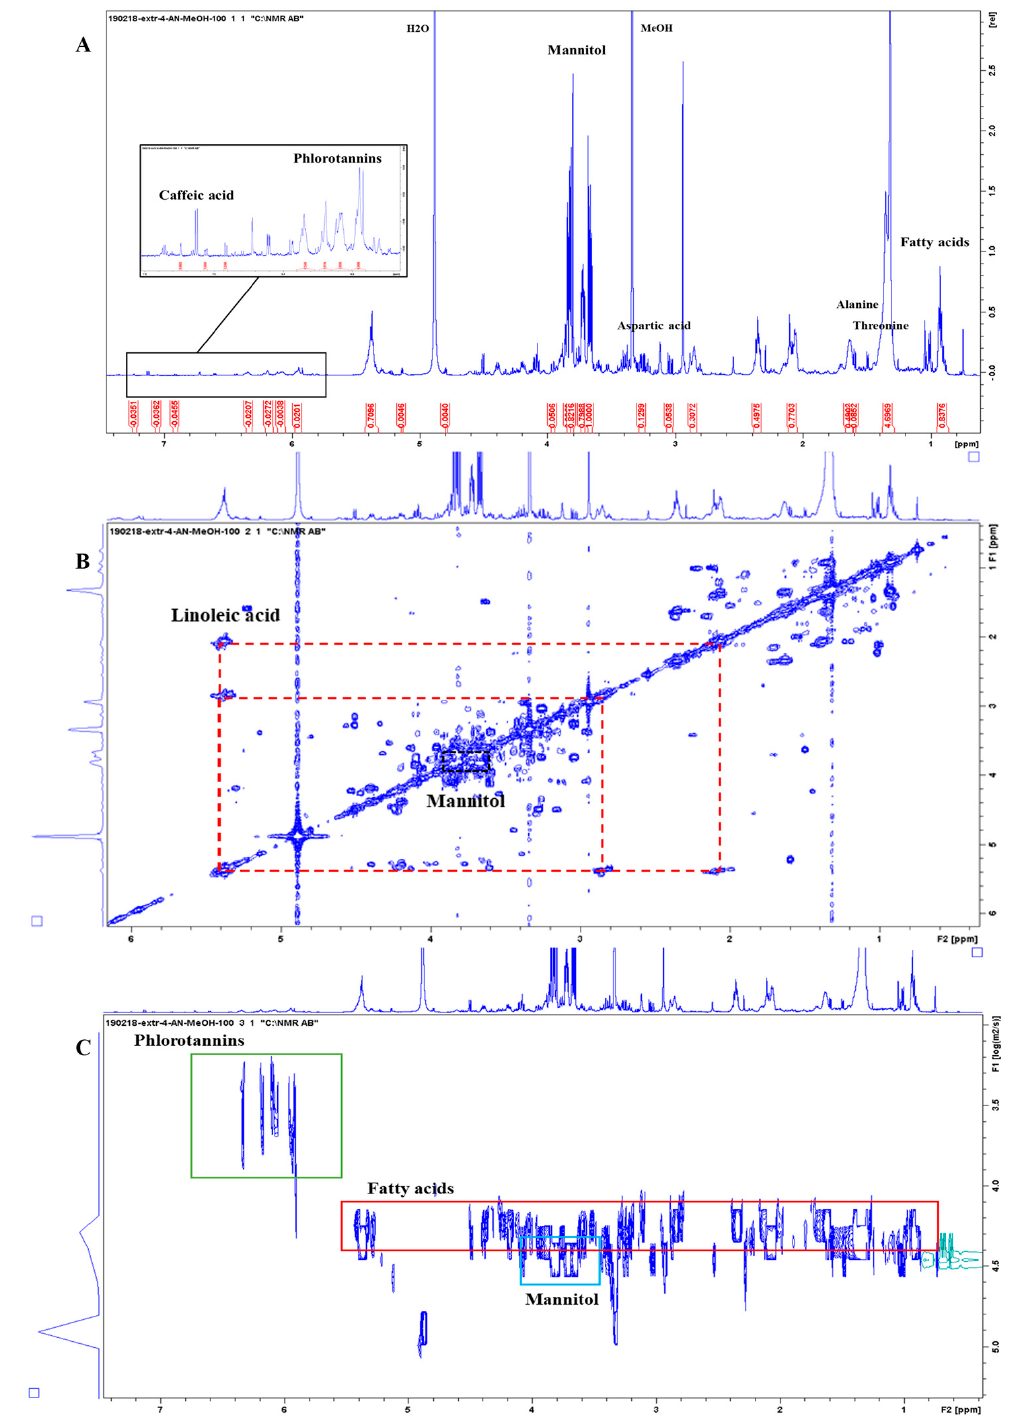
Figure 4. NMR spectra of Ascophyllum nodosum extract (CH 3 OH extraction). ( A ) The 1D 1 H-NMR spectrum with a selection of metabolites highlighted. The aromatic regions are not shown here for clarity reasons and full spectra are provided in the Supplementary Materials. ( B ) The 2D 1 H- 1 H- COSY NMR spectrum with representative off-diagonal cross peaks indicated for mannitol and linoleic acid. ( C ) The 2D 1 H- 1 H-DOSY NMR spectrum with the green, red, and blue boxes highlighting the phlorotannins, fatty acids, and mannitol signals, respectively, separated according to their different diffusion